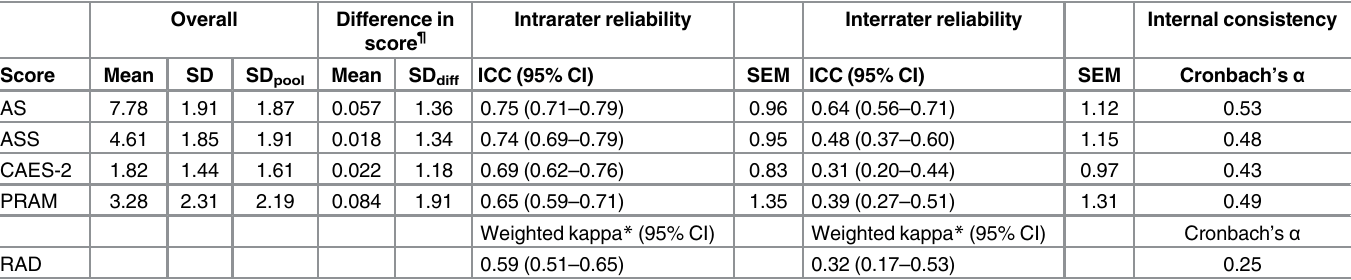
Table 5. Inter and intrarater reliability and internal consistency of the five dyspnoea scores.